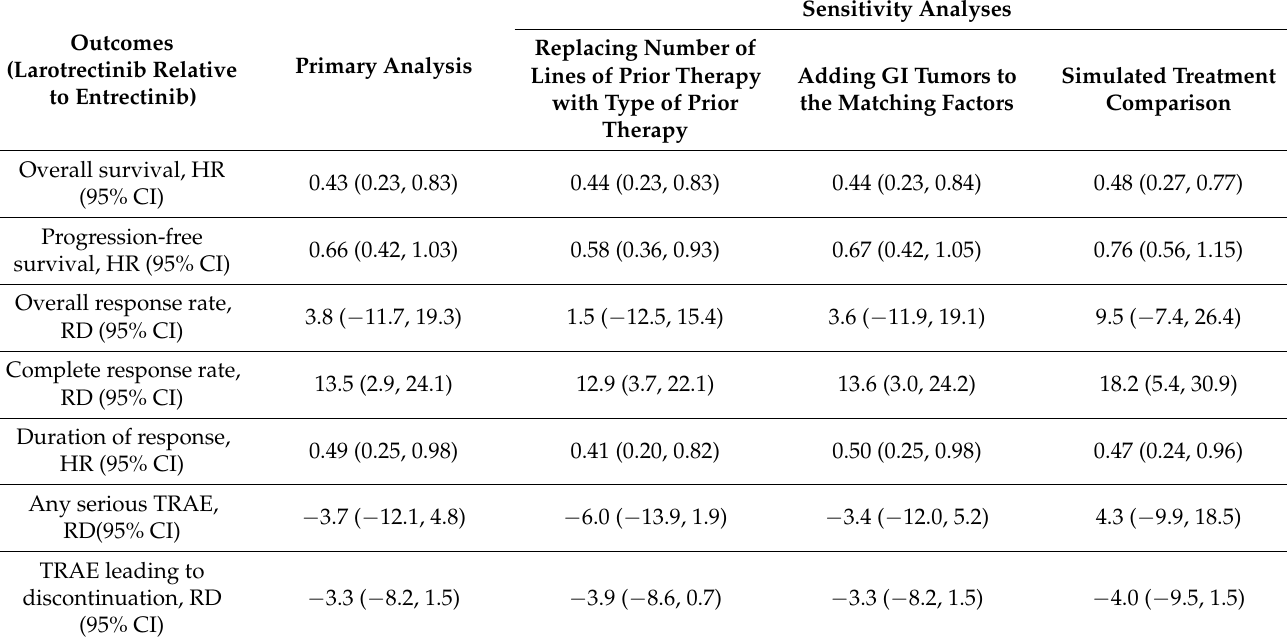
Table 5. Treatment differences in the primary and sensitivity